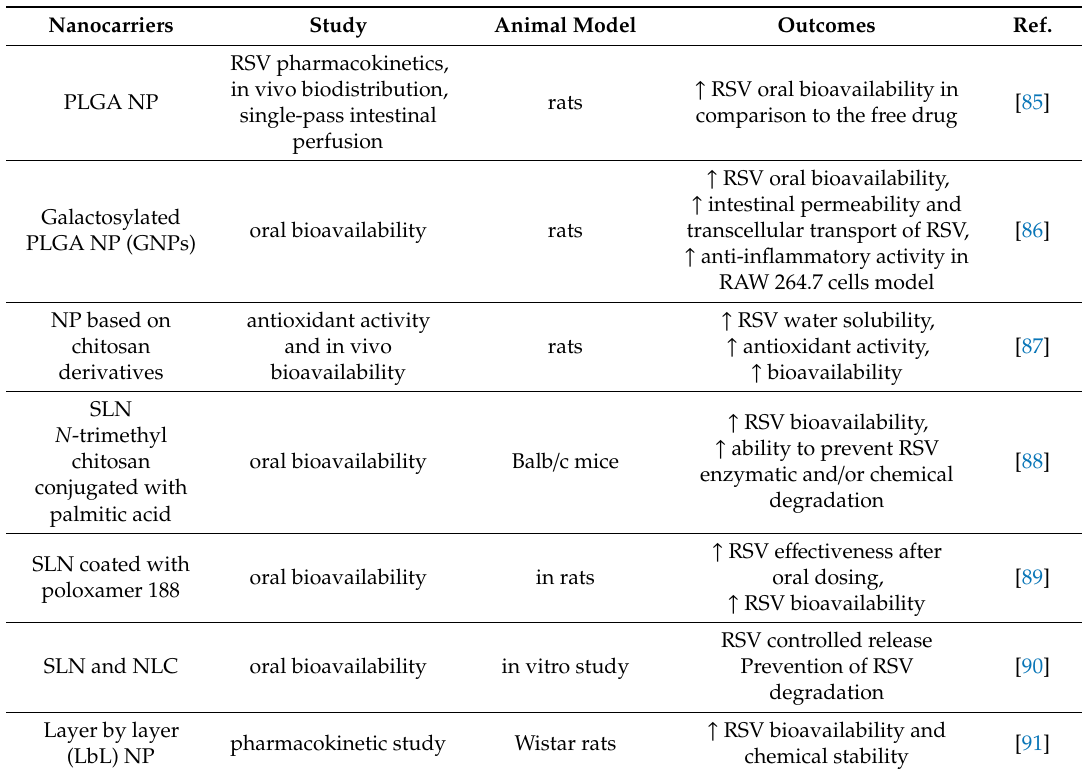
Table 2. Oral resveratrol (RSV) drug delivery systems. NP = nanoparticles; PLGA = dl -lactide- co -glycolide; SLN = solid lipid